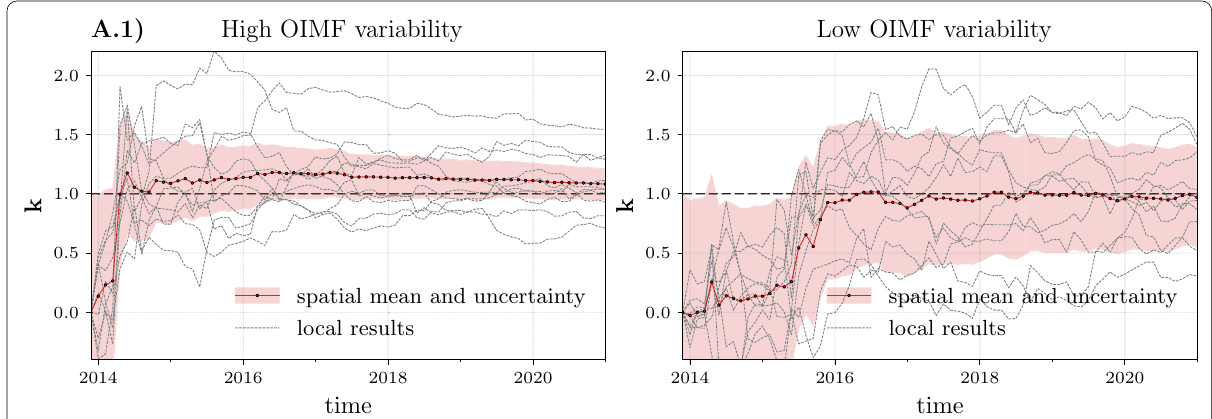
Fig. 5 The evolution of the scale factor over the entire assimilation period. The convergence of the scale factor is considered in two different areas: an area of high OIMF variability located in the Southern Indian Ocean (left side) and an area of low OIMF variability located in the Eastern Pacific (right side). The grey lines denote the point‑wise local factors, and the red lines highlight the area’s spatial averaged mean and uncertainty (posterior standard deviation). The horizontal, dashed, black line indicates the true scale